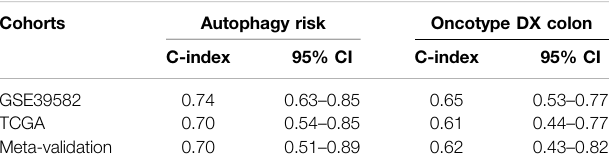
TABLE 3 | C-index for autophagy risk compared with Oncotype DX colon in three